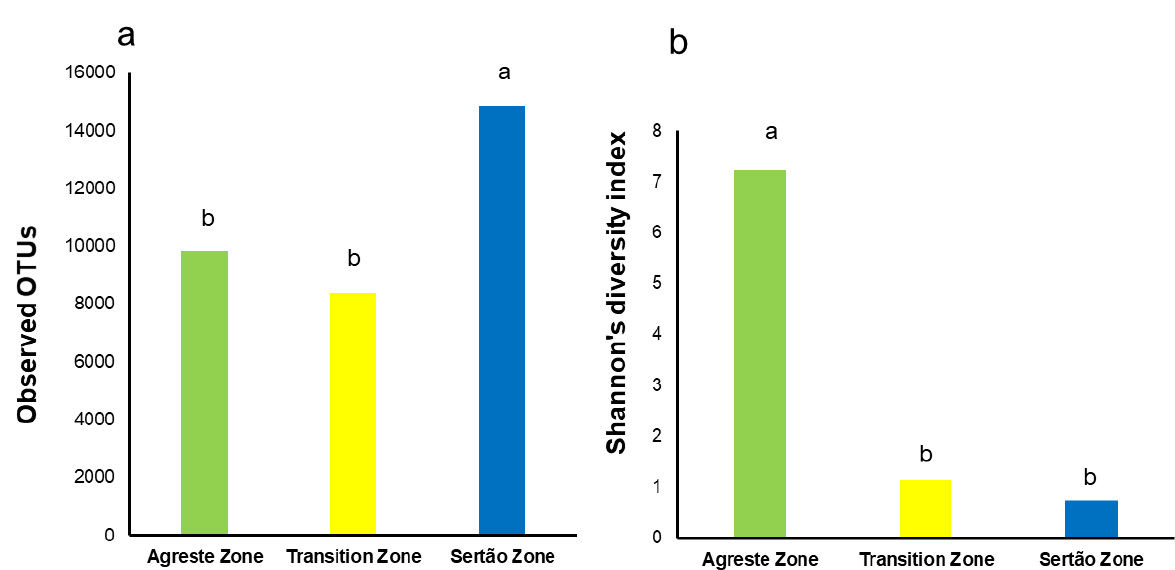
Figure 1. Observed OTUs (a) and Shannon’s diversity index (b) in the mesoregions of the State of Pernambuco. Different lowercase letters refer to significant differences between treatments based on Tukey’s HSD test (P <